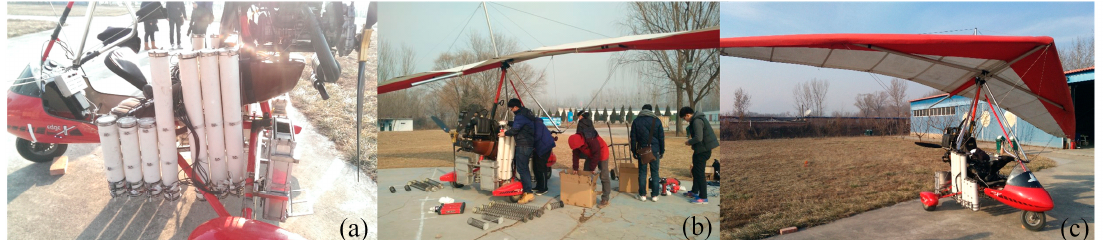
Figure 12. Preparation for the integrated demonstration: ( a ) Equip airplane with launch cabins. ( b ) Load ground robots, separation devices, and parachutes into launch cabins. ( c ) Preparation is done.